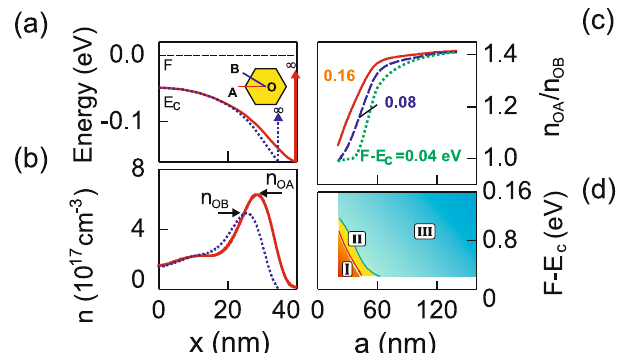
Figure 3. ( a ) The conduction band diagram plotted in the direction towards the nanowire corner (solid line) and the middle of the nanowire facet (dotted line) for the intrinsic InAs nanowire with a = 40 nm at T = 4 K. Inset: Sketch of a nanowire cross section with the indicated corner direction (OA) and facet direction (OB). ( b ) Three-dimensional electron density as a function of the coordinate plotted in the direction towards the nanowire corner (solid line) or middle of the nanowire facet (dotted line) for the intrinsic InAs nanowire with a = 40 nm at T = 4 K. ( c ) Ratio of the maximum electron density in the corner direction ( n OA ) to the maximum electron density in the facet direction ( n OB ) as a function of the nanowire side length a ( T = 4 K). The Fermi level is positioned at the surface 0.04 (dotted line), 0.08 (dashed line), and 0.16 eV above the conduction band edge. ( d ) Two dimensional diagram of various electron distributions: (I) the centered distribution, (II) the tubular distribution, (III) the tubular distribution with the additional electron accumulation regions at the